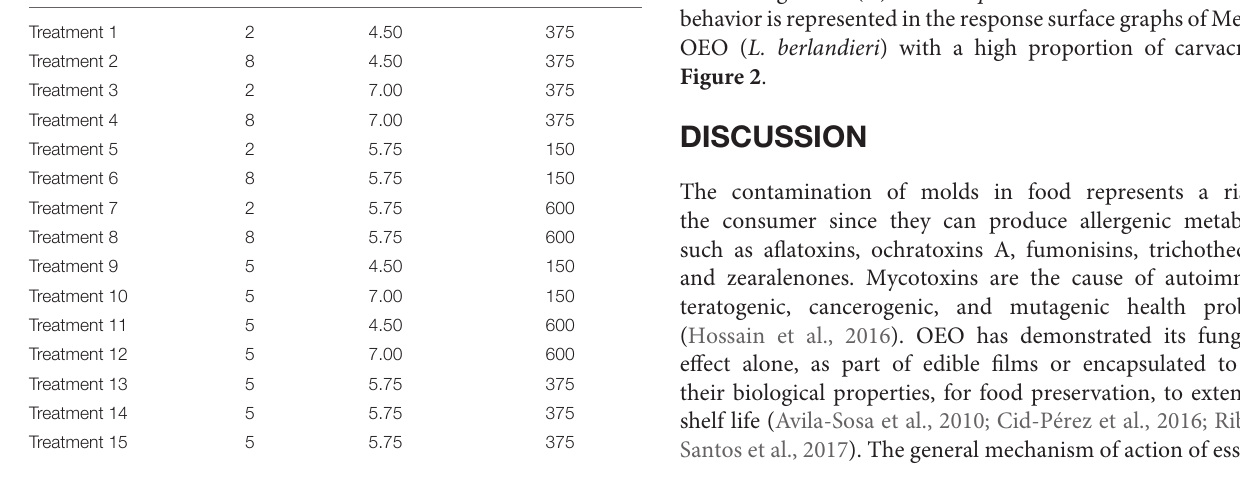
essential oil (mg/L)